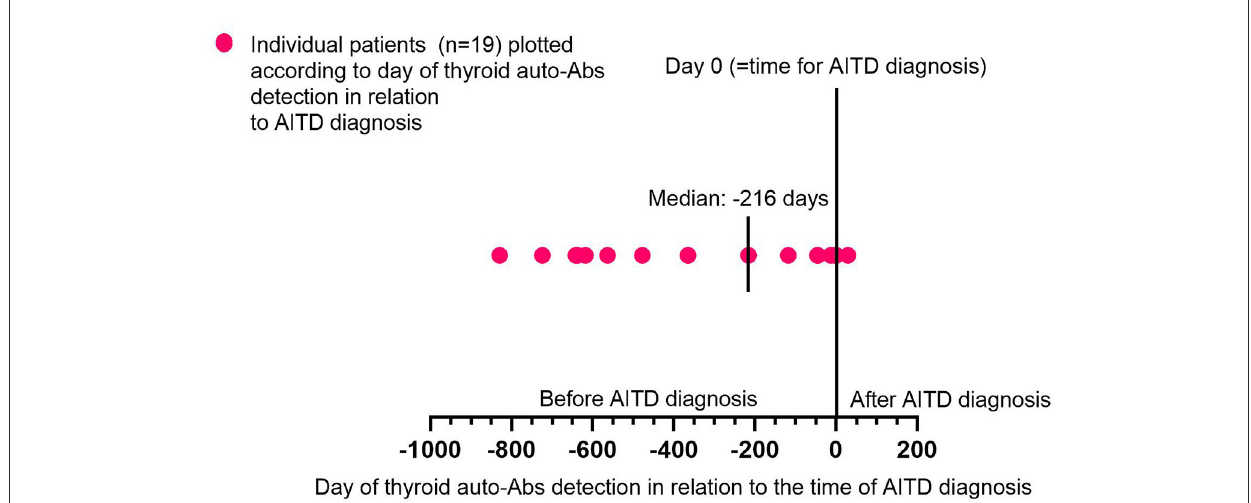
FIGURE2 Time of thyroid auto-Abs detection in relation to AITD diagnosis. Graph shows individual patients ( n = 19) plotted according to the day of thyroid auto-Abs detection in relation to the time of AITD diagnosis. The x-axis shows the timeline for days before (–) and after ( + ) the day of AITD diagnosis ( = day 0). On the graph is also the median time for thyroid auto-Abs detection in relation to the AITD diagnosis highlighted. Auto-Abs, autoimmune antibodies; AITD, autoimmune thyroid disorder.